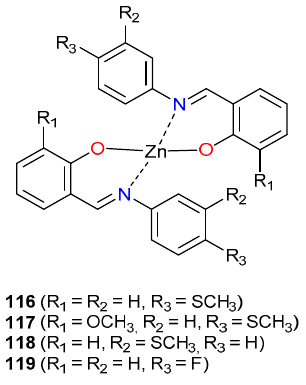
Figure 20. Schiff-base Zn complexes 116–119 [76]. Figure 20. Schi ff -base Zn complexes 116–119